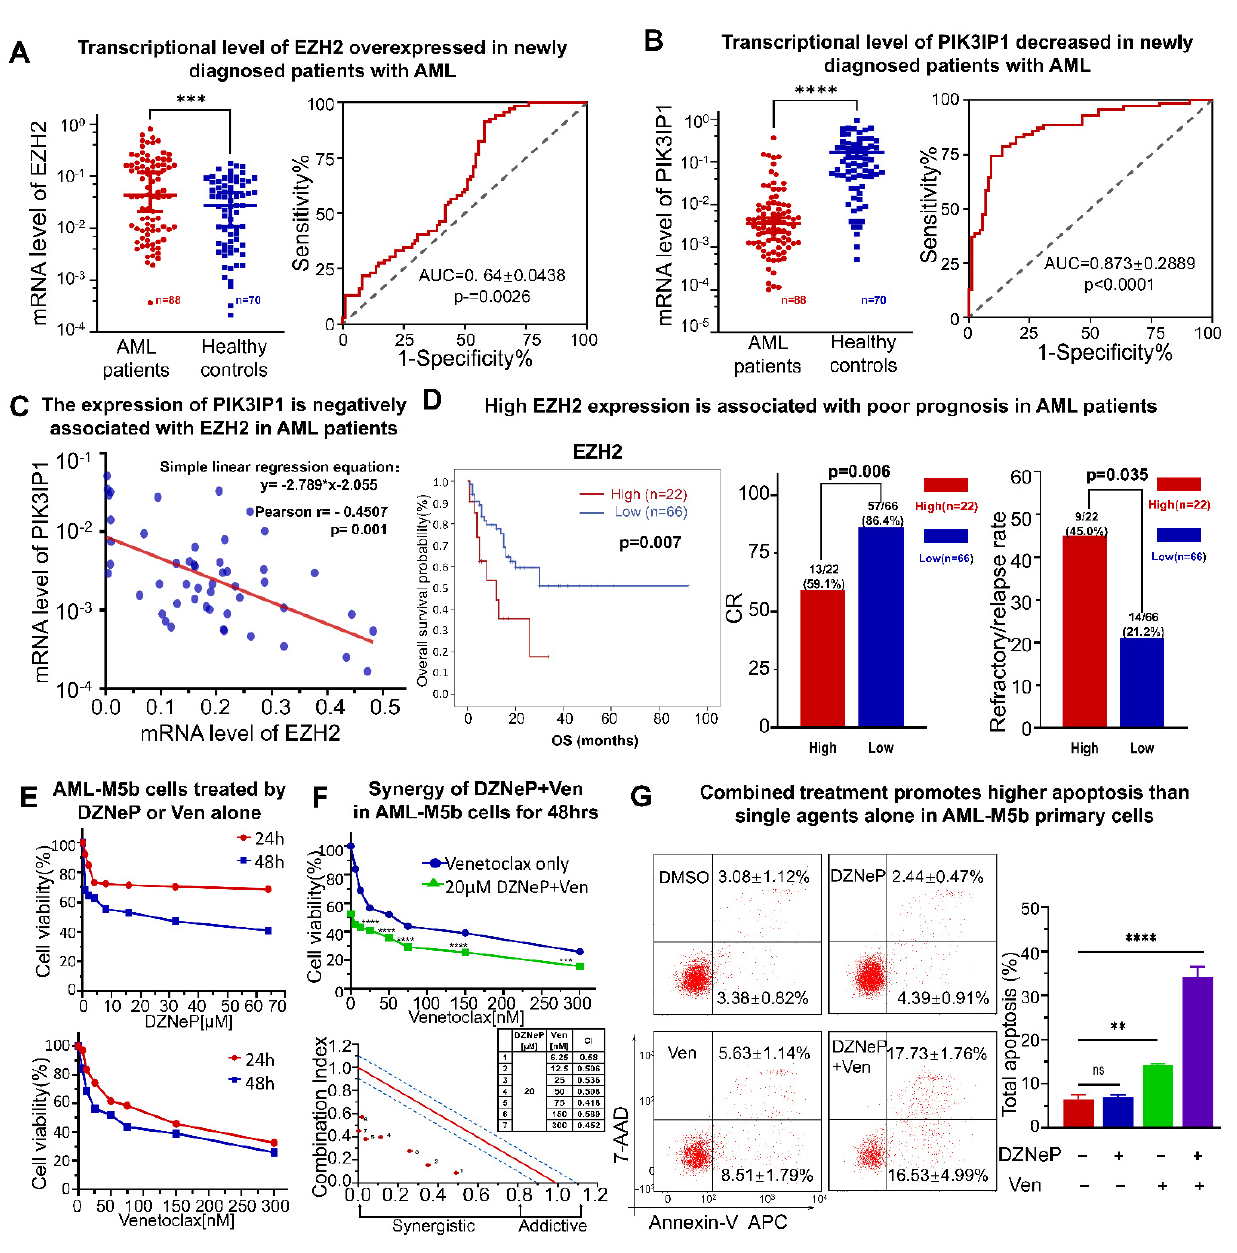
Figure 5. A high expression of EZH2 is associated with poor outcomes in patients with AML and the synergistic effect of DZNeP + Ven in AML-M5b primary blasts. ( A , B ) A qRT-PCR assay was performed to measure the expression of EZH2 and PIK3IP1 in newly diagnosed AML patients’ bone marrow samples ( n = 88) compared to the healthy donors’ PBMC samples ( n = 70). ( C ) Pearson correlation and a simple linear regression analysis were conducted to show the associated relationship between EZH2 and PIK3IP1. ( D ) Comparison of overall survival (OS), % complete response (CR) rate, and refractory/relapse rate in patients with an EZH2 high expression (high) versus an EZH2 low expression (low) in our AML cohort. ( E ) Effects of DZNeP or Ven single agents on cell growth inhibition in AML-M5b primary blasts. Cells were treated with the indicated doses of drugs for 24 and 48 hrs. Cellular viability was measured by a CCK-8 assay. ( F ) Synergistic effects of Ven in combination with 0 and IC50 doses of DZNeP on cell growth arrest in AML-M5b primary blasts. Synergistic analysis was performed with Calcusyn, where a combination index value of 1.1 to 0.9 is considered an additive effect, <0.9 is a synergistic effect, and >1.1 is an antagonistic effect, respectively. ( G ) Effects of DZNeP (20 μ M), Ven (50 nM), and the combination of DZNeP plus Ven on apoptosis in AML-M5b primary cells. Cells were treated for 48 hrs and were stained with hCD34, hCD117 surface biomarkers, the apoptotic antibody 7-AAD, and annexin V APC for flow cytometry analysis. The flow cytometry gating strategy was used for determining the apoptosis rate of the CD34/CD117 dual-positive AML blast subpopulation. The percentage of the total apoptosis rate is calculated with